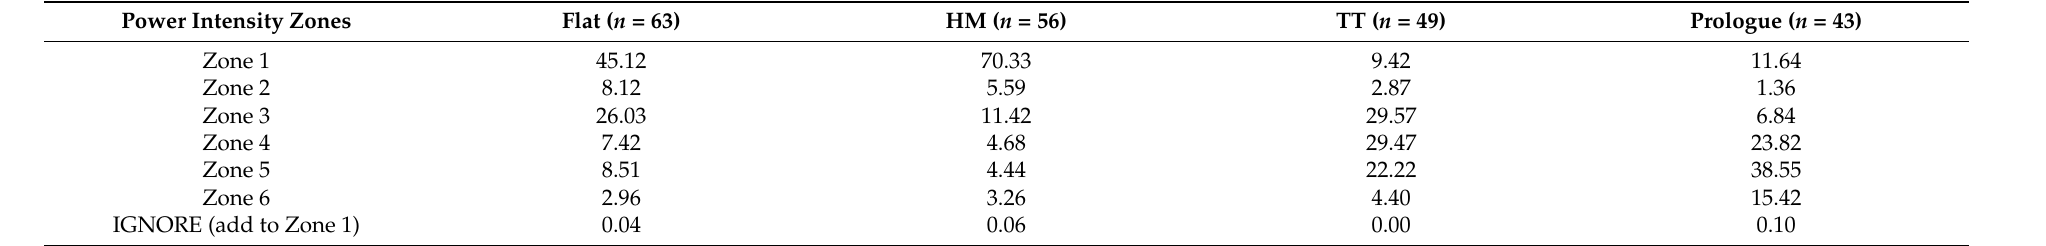
Table 2. Average percentage time spent at a given zone (% tZ i ) in each of the four stage types. Data from professional WorldTour